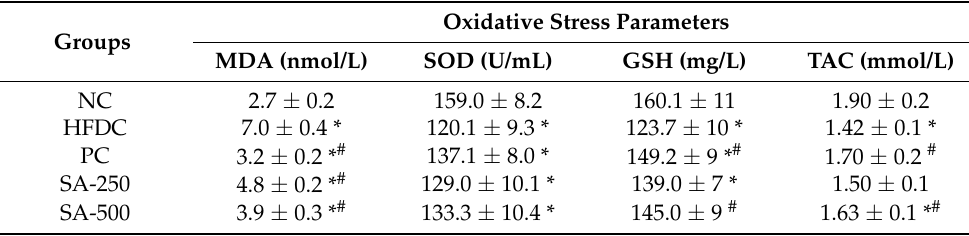
Table 4. Effect of star anise tea and orlistat treatment on the oxidative stress parameters of different groups of obesity rat